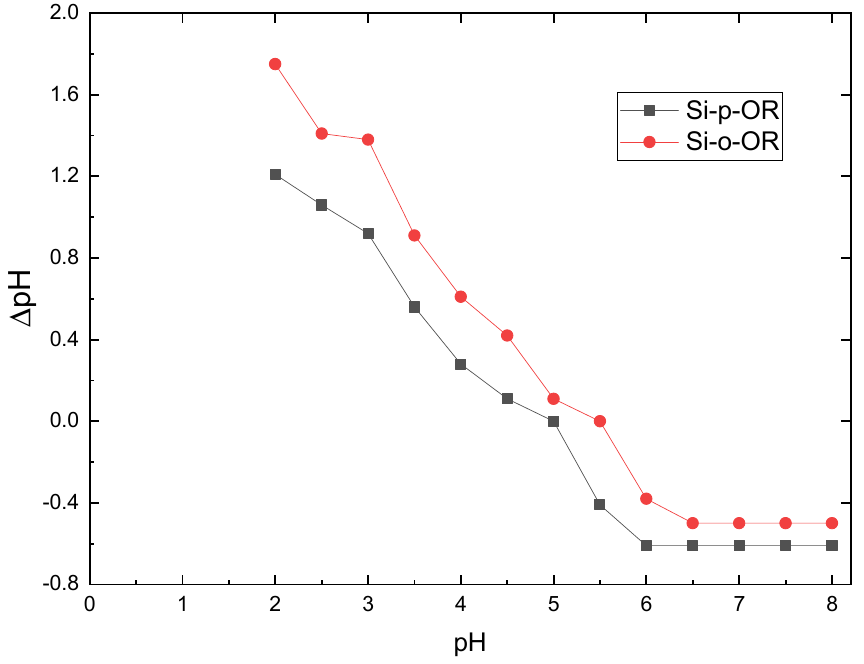
Figure 6. pH PZC determination of Si-o-OR and Si-p-OR at different pH values. Adsorption condi- tion: V = 10 mL, m = 10 mg of adsorbent and optimum concentration = 120 mg L − 1 for 25 min at 25 °C.